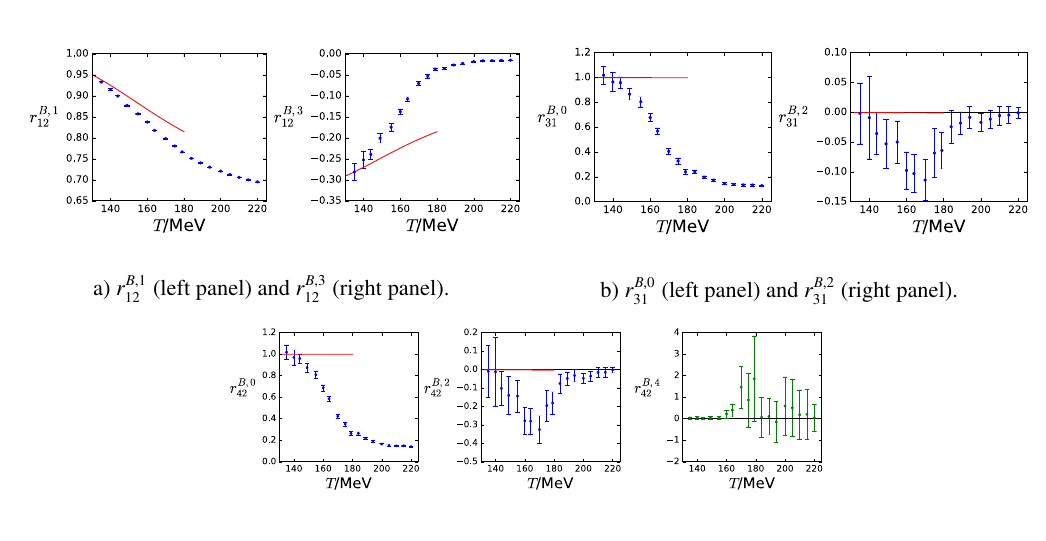
Figure 2: Taylor expansion coe ffi cients as functions of the